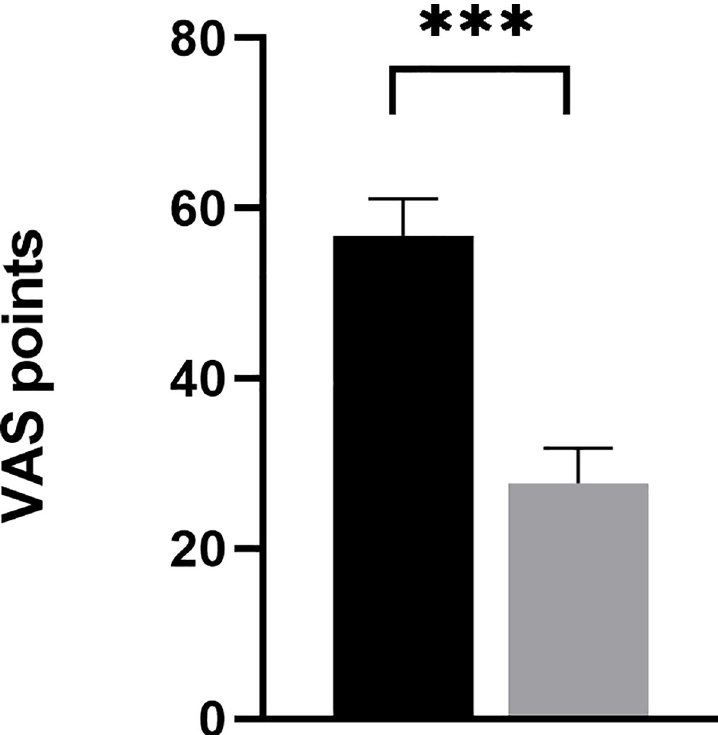
Fig 2. Vasoactive score (VAS) for catecholamines before and after cytokine adsorption. Graph shows vasoactive score (VAS) for catecholamines required to reach a mean arterial pressure (MAP) � 65 mmHg before and after cytokine adsorption. Data include n = 76 patients. Error bars correspond to SEM. Asterisks mark differences between both groups at a significance ��� p <